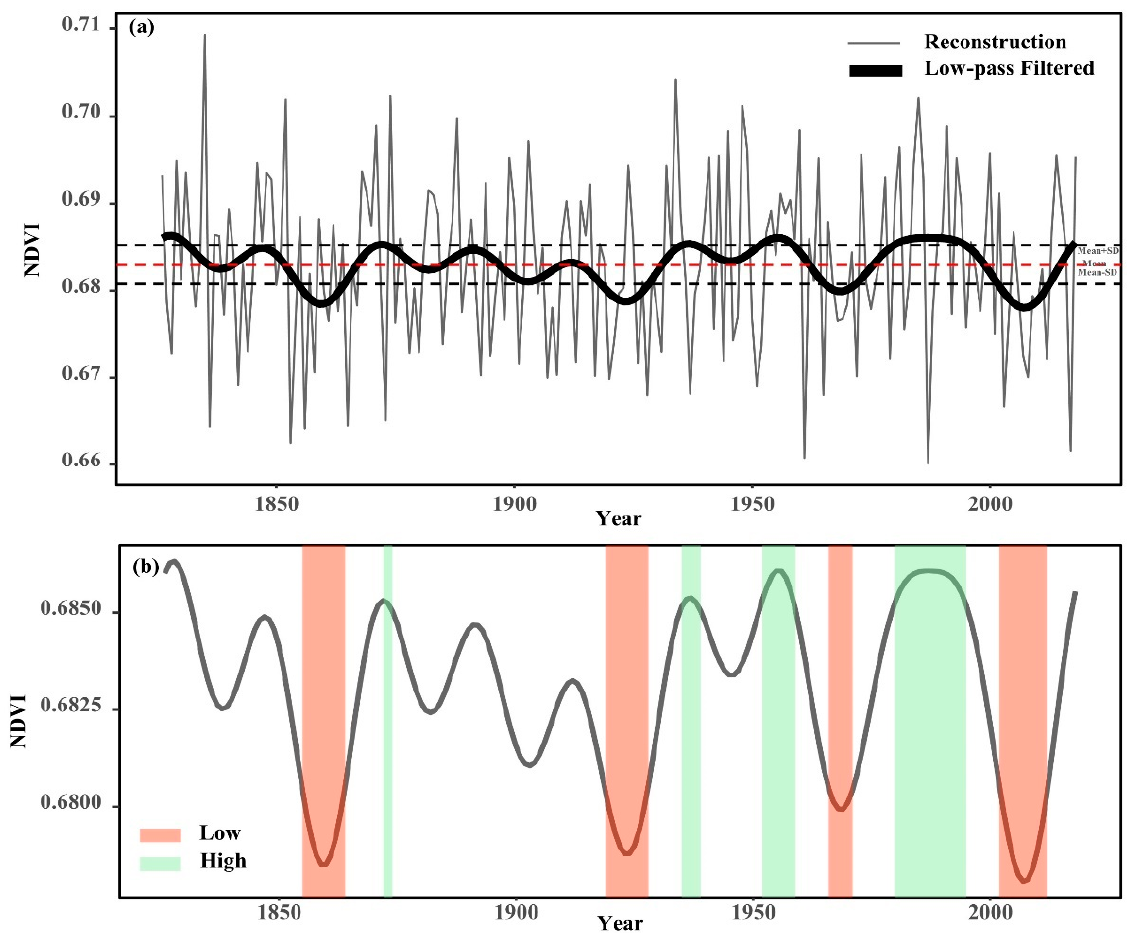
Figure 6. ( a ) NDVI 5–9 curve after 20 years of low-pass filtering (thick line). The thin line represents the reconstructed NDVI 5–9 , and the horizontal line indicates the mean and mean ± one standard deviation. ( b ) Time interval between the occurrence of extreme events such as low and high cover during the reconstruction interval. The thick lines represent 20 years of low flux data. The red shaded areas represent low cover intervals, and green shaded areas represent high cover intervals.